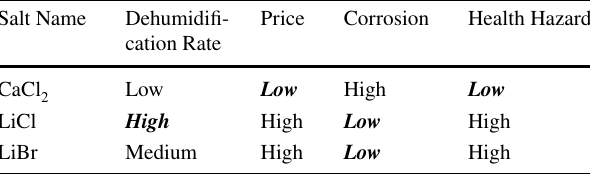
Table 1 The amount of moisture absorption depends on the salt type